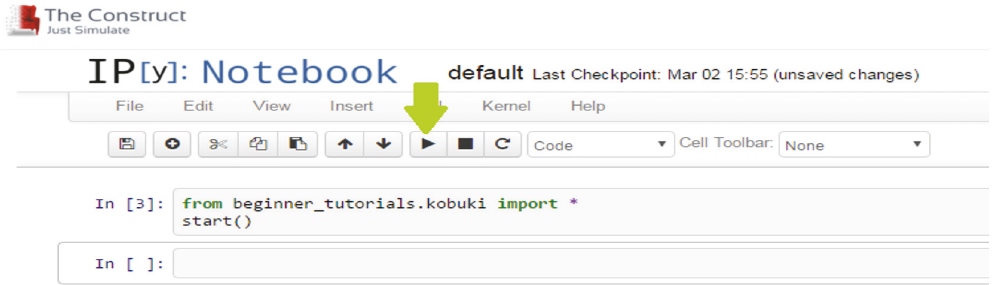
Figure 12: Jupyter Notebook. The green arrow marks the run